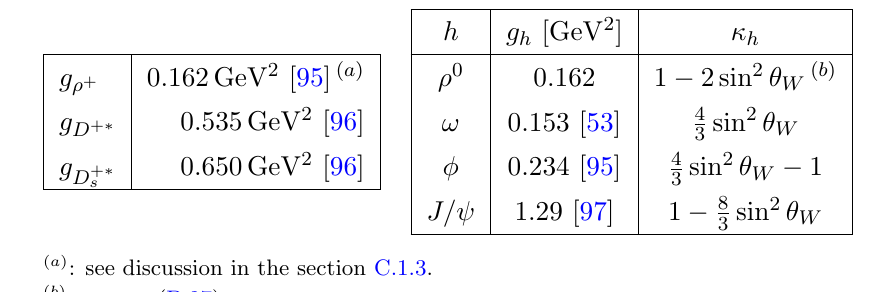
Table 8 . Decay constants of pseudoscalar charged mesons (left table) and pseudoscalar neutral mesons (right table).